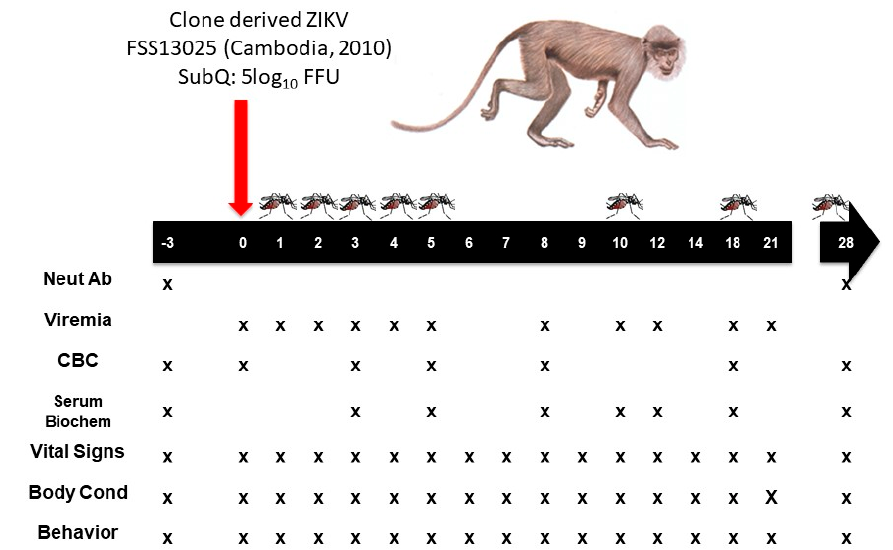
Figure 1. Experimental design and timeline. Monkeys were infected with 5 log 10 FFU of cDNA clone-derived ZIKV strain FSS13025 on day 0. Samples (blood, urine, tears and saliva) were taken 3 days prior to infection and on 1, 2, 3, 4, 5,8, 10, 12, 18, 21, and 28 days post infection (dpi). All animals underwent terminal sampling and necropsy 28 dpi to detect any persistent infection or tissue damage due to infection.